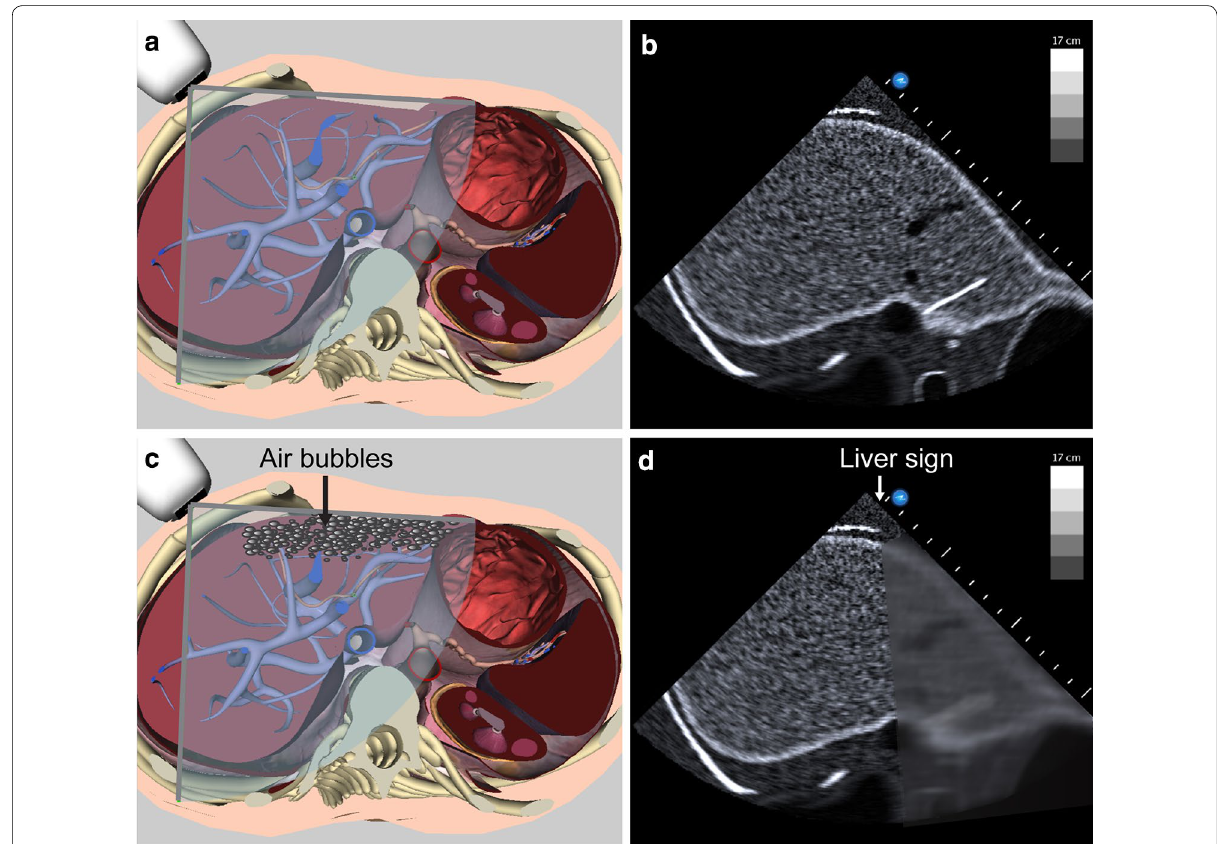
Fig. 1 Pneumoperitoneum. a , b Normal aspect of the liver using a transverse view at the anterior axillary line. c When air is present in the abdomen, it will typically accumulate in the non‑dependant region just anterior to a portion of the liver. d When the ultrasound beam is positioned over this area, the normal acoustic aspect of the liver will be followed by a sharply demarcated acoustic shadow. The term “liver sign” can be used to describe this abnormal air‑liver interface. Anatomical and two‑dimensional plane using the Vimedix simulator with permission of CAE Healthcare, Ville St‑ Laurent, QC,